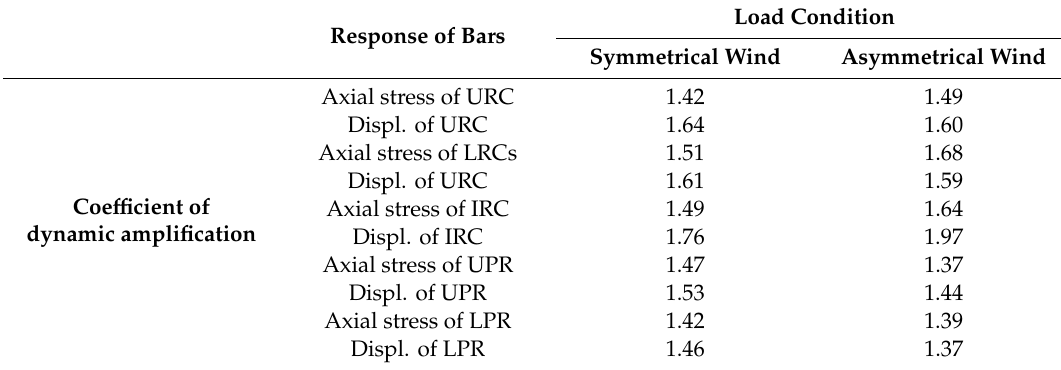
Table 1. Calculation results of wind-induced vibration. Load Condition Response of Bars Symmetrical Wind Asymmetrical